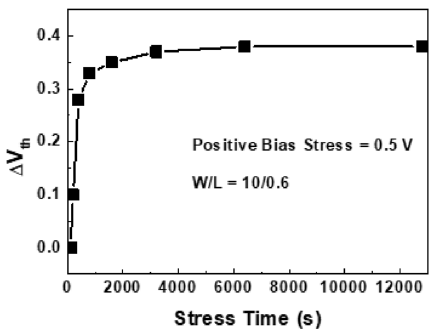
Figure 6. Threshold voltage shift during positive gate bias stress.